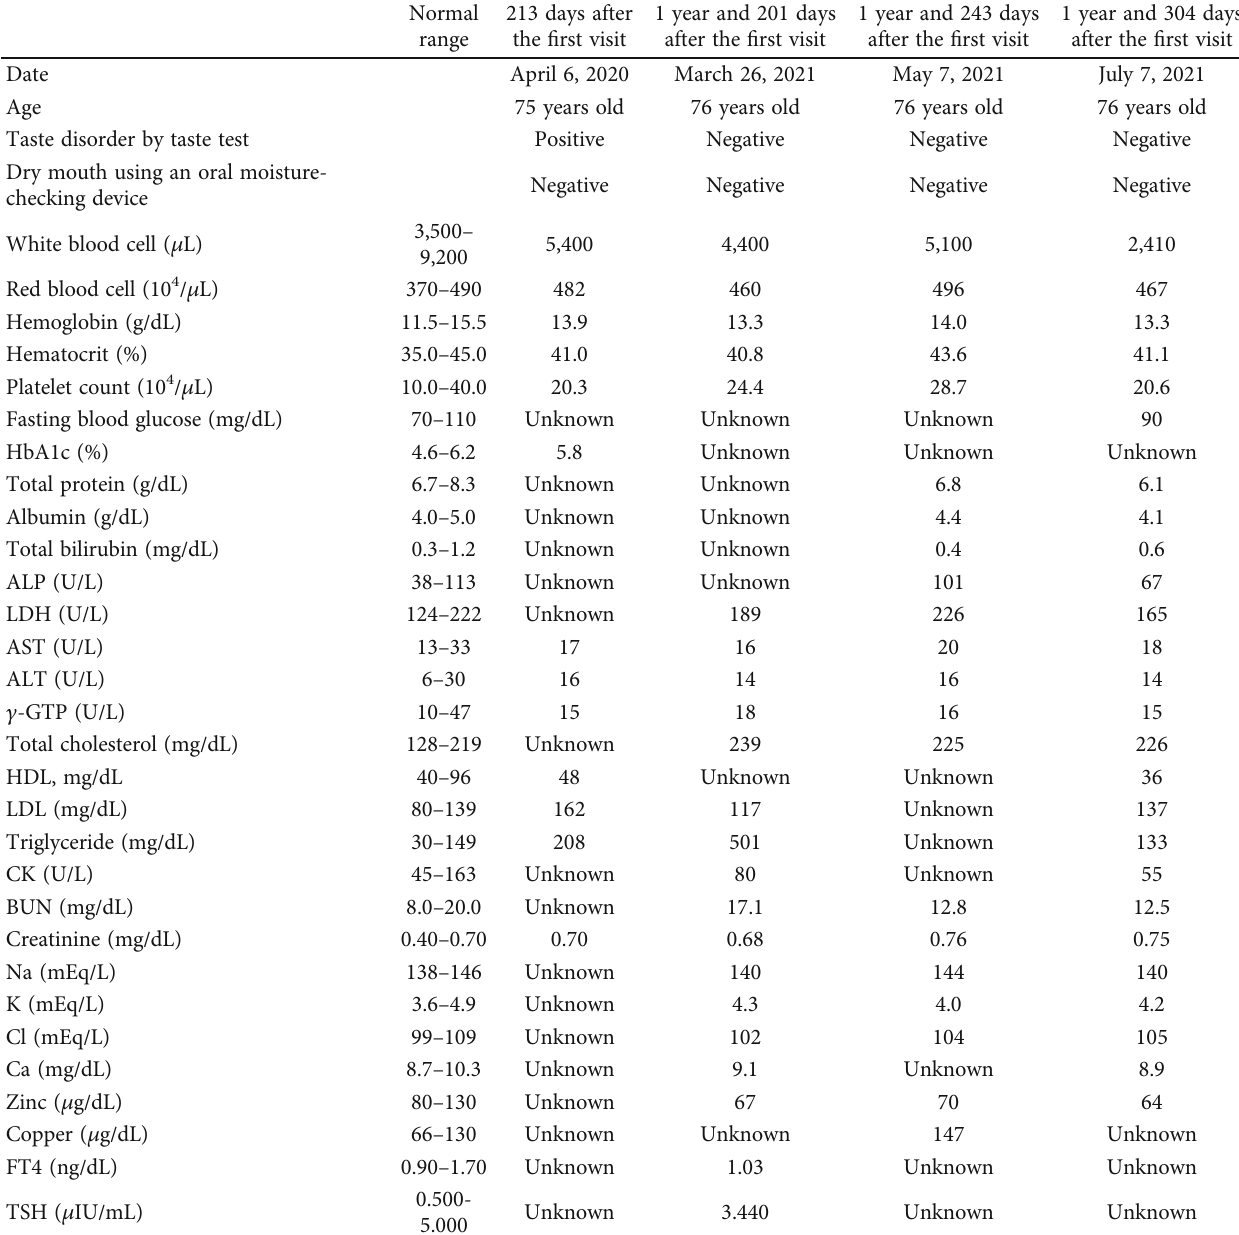
Table 3: Summary of laboratory